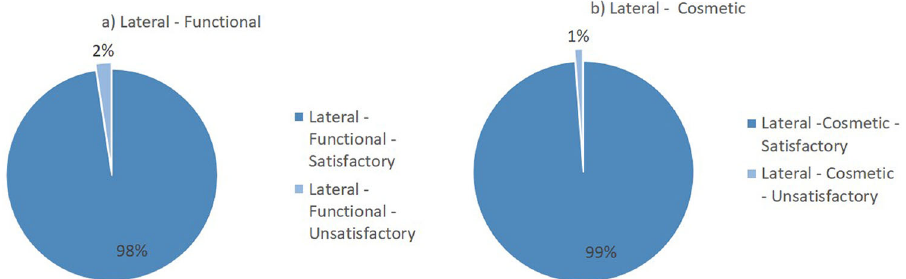
Figure 2. Outcomes of the lateral surgical approach based on Flynn ’ s criteria: (a) functional outcome and (b) cosmetic outcome.